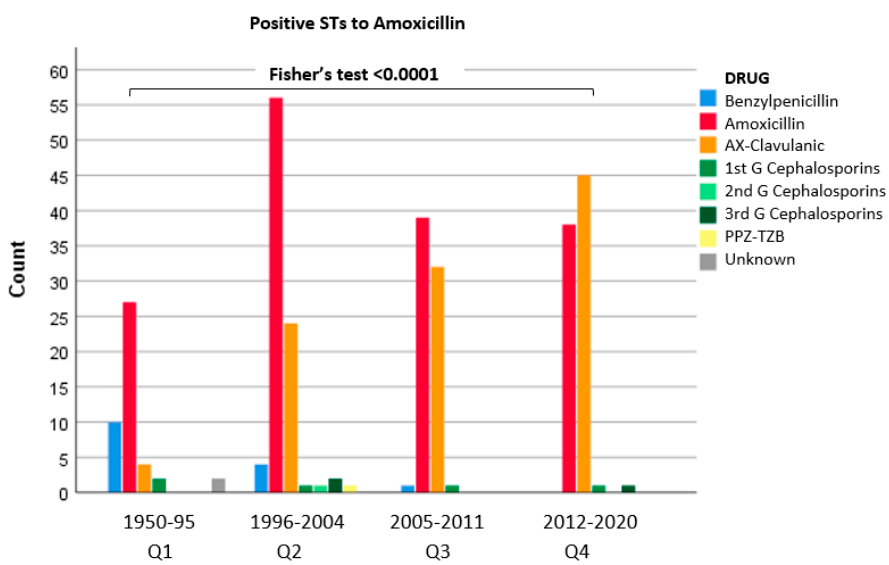
Figure 2. Positive STs with amoxicillin related to the eliciting BL. Other BLs also were tested in 182 patients (29.4% of patients), yielding positive results in 152 (24.7%). The percentage of positive STs was 12.5% for Q1, whereas Q2, Q3, and Q4 showed similar proportions (29.1%, 24.3%, and 24.7%, respectively). It should be noted that the progressive increase in the number of patients who were tested with other BLs required years to be diagnosed, from 18 in Q1 to 52 in Q4. When comparing Q1 with the rest of the quartiles, a significant difference was found (Fisher’s test p < 0.0001) (Figure 3).